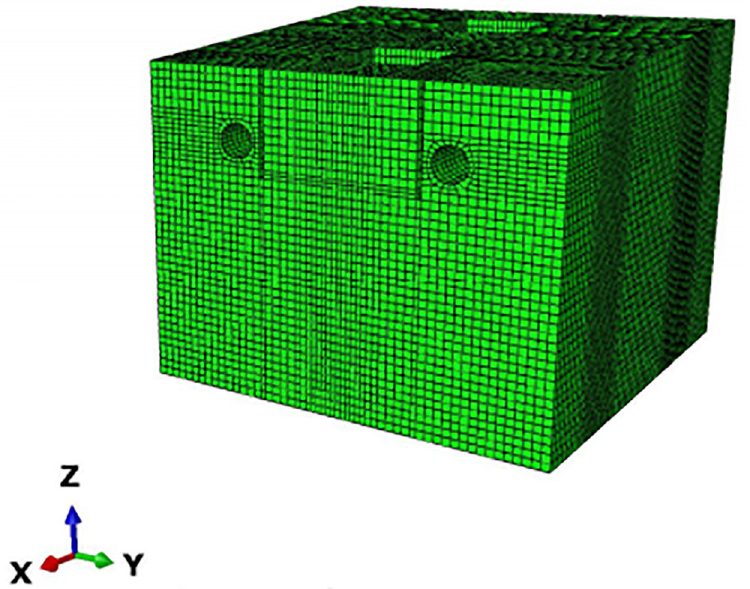
Fig 6. Soil model meshing results.